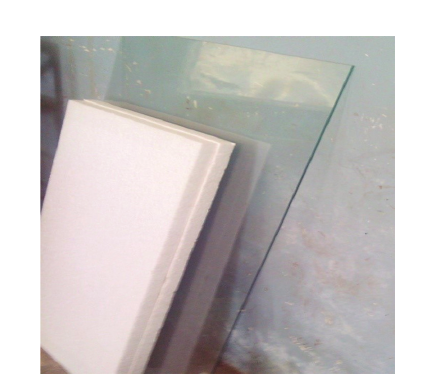
Figure 4: Glass used in this